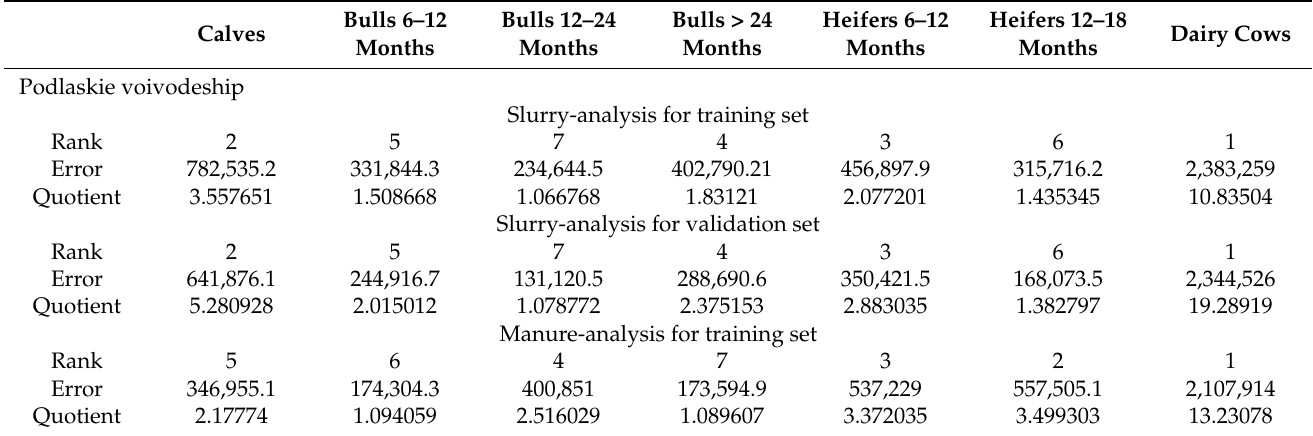
Table 5. The sensitivity analysis of the input variables for the examined output